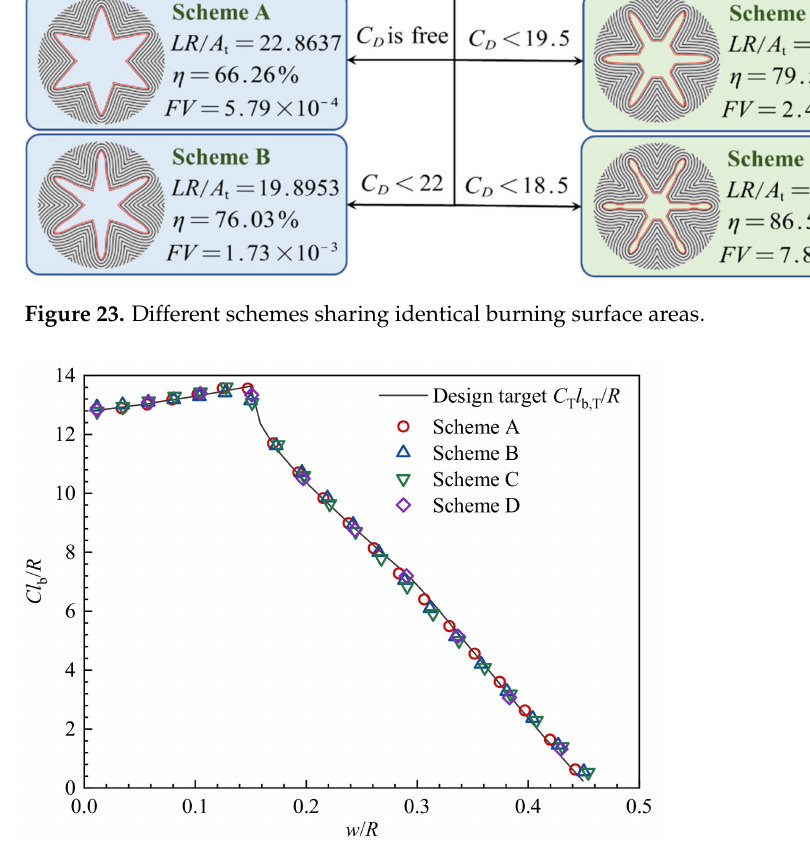
Figure 24. Dimensionless burn perimeter of the